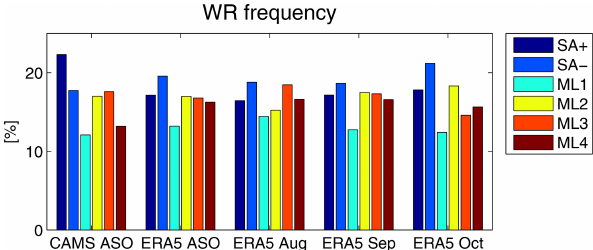
Figure 7. WR frequency in CAMS (computed in the period 2003– 2017) and ERA5 (computed in the period 1981–2020) classifica-